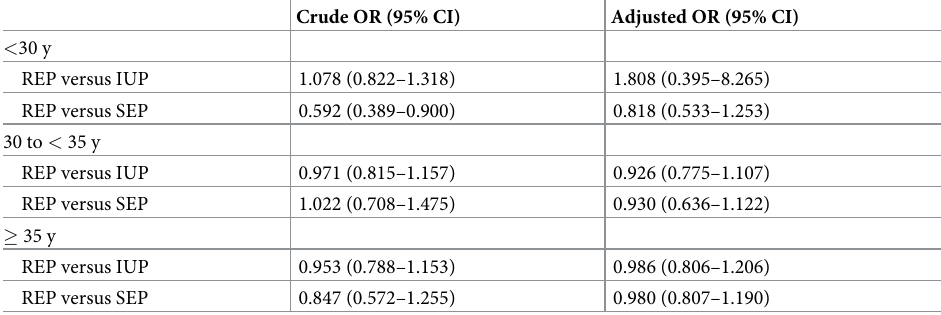
Table 5. Crude and adjusted odds ratios (ORs) of live birth after REP versus other pregnancy histories.